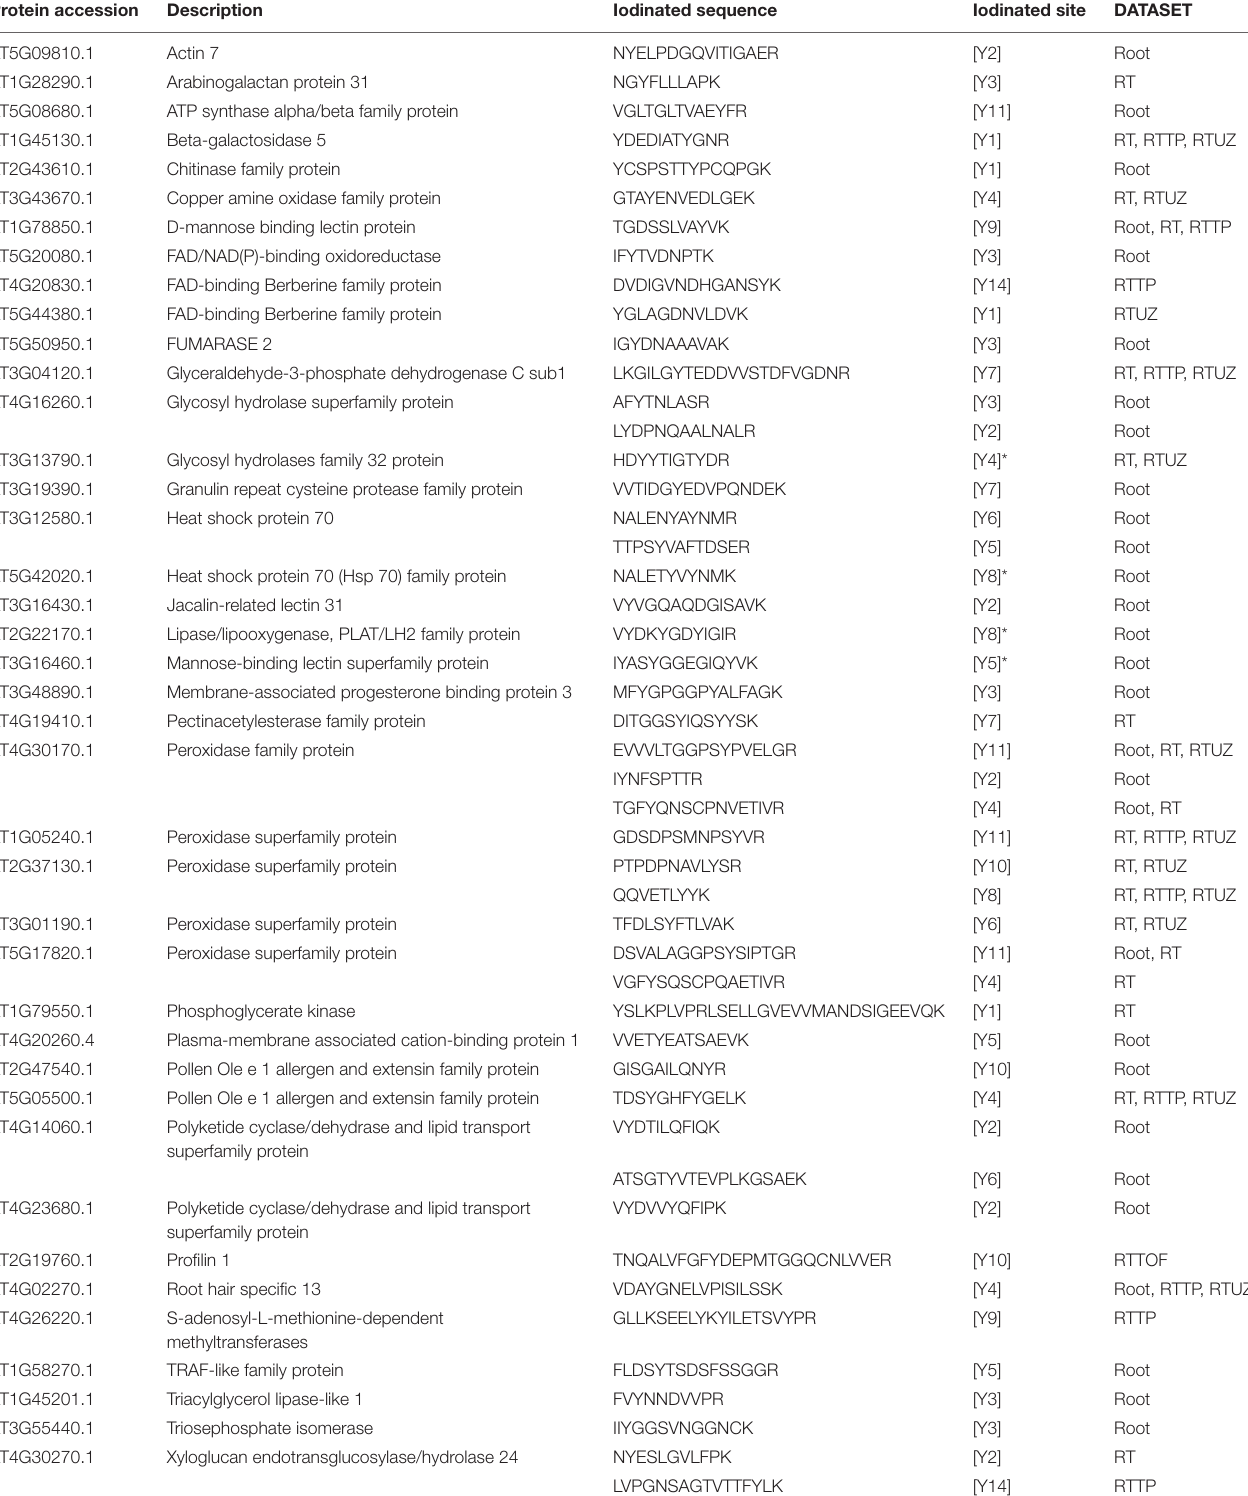
TABLE 2 | Iodinated peptides identified in A. thaliana roots by database searching of mass spectrometric data retrieved from PRIDE repository. Protein